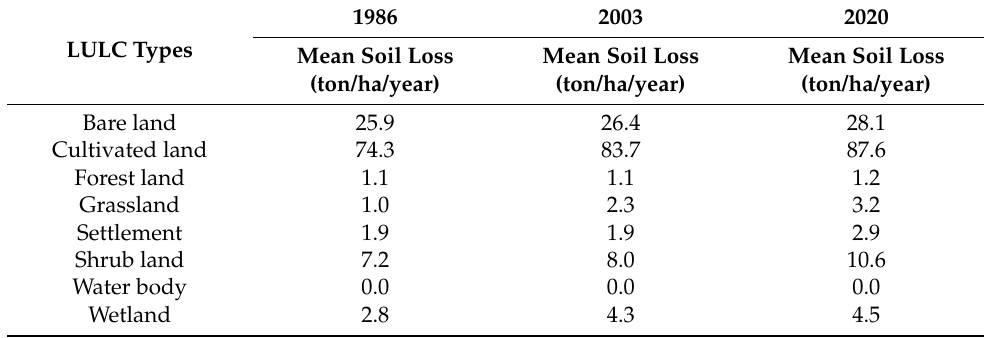
Table 8. Mean soil loss rate across different LULC classes in the Muger Sub-basin.